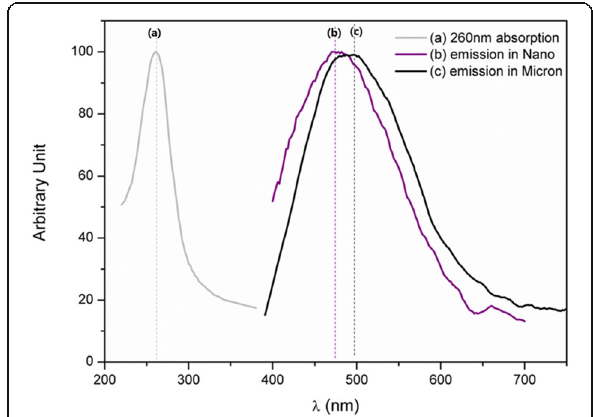
Fig. 2 Photoluminescence of Ti-doped MgAl 2 O 4 : a 260 nm excitation, b nano, and c micron [12] powders synthesized at 500 °C, 1 h, and 1300 °C, 2 h, respectively